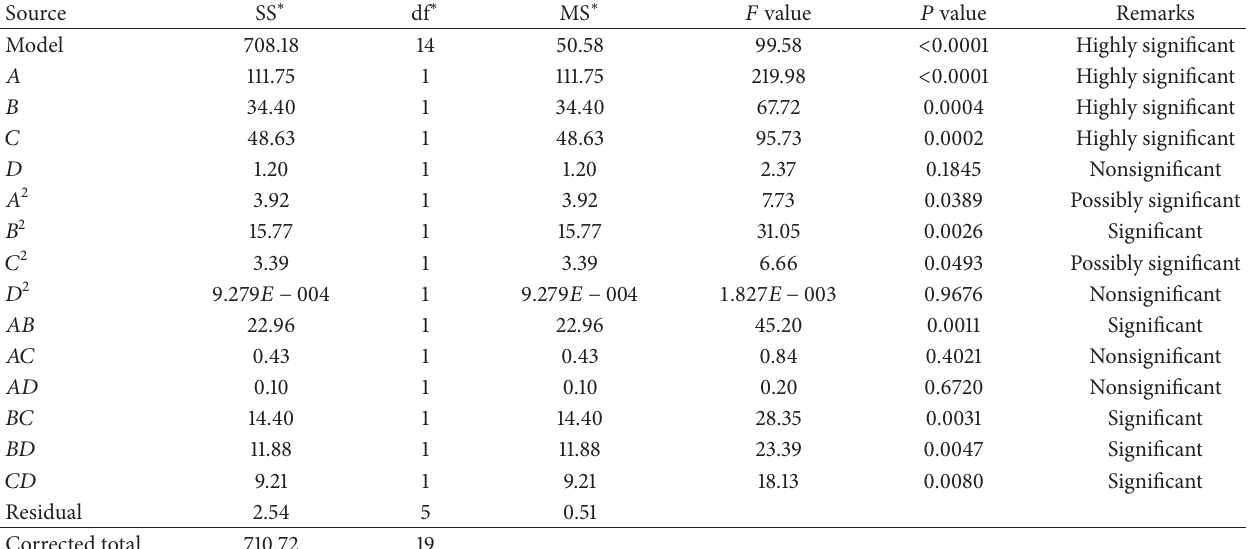
Table 5: Analysis of variance of the fitted quadratic regression model (4).